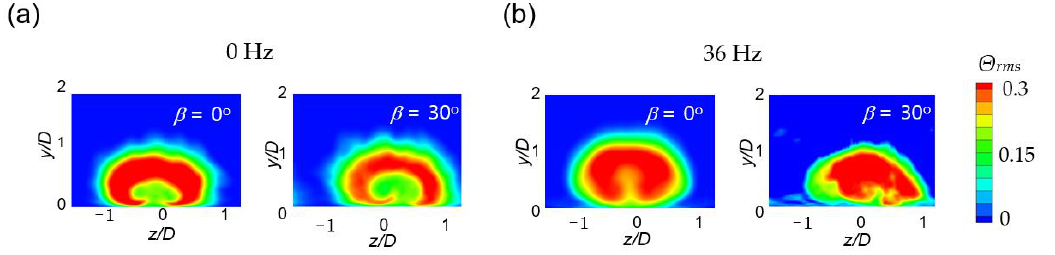
Figure 15. Temperature fluctuations at x / D = 2.5 [77]: (a) M = 0.5, steady; and (b) M = 0.5 with bulk-flow pulsation.